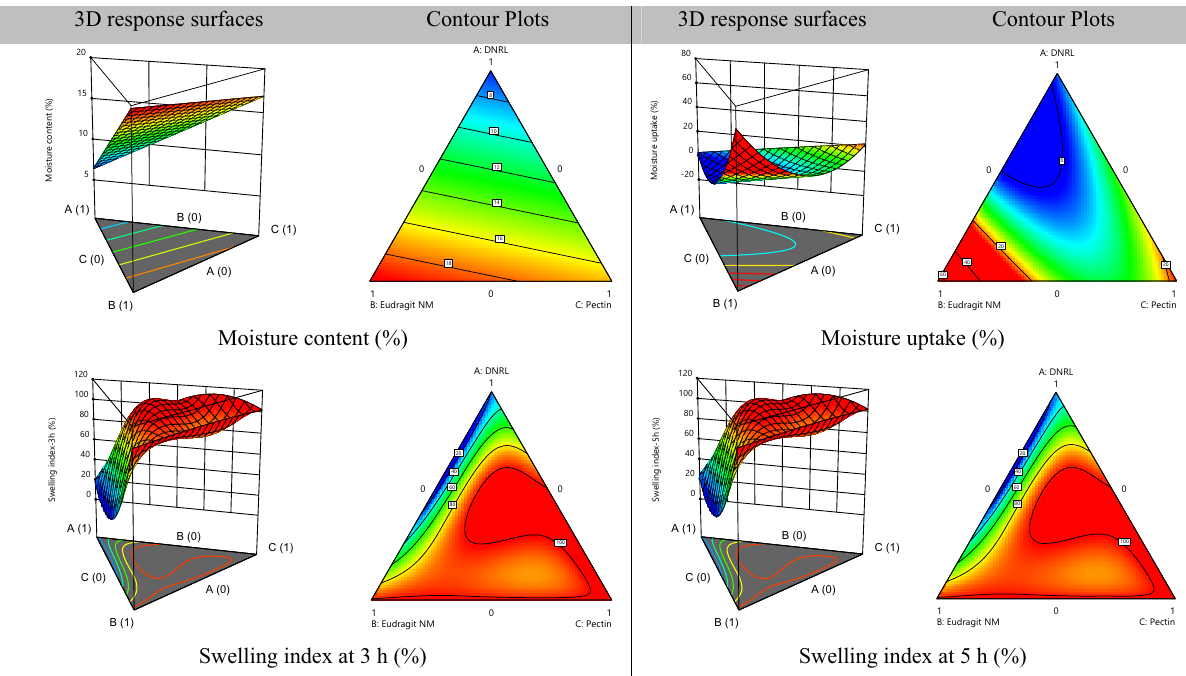
Figure 1: 3D response surface and contour plot of nicotine buccal fi lm formulations with di ff erent dependent variables: moisture content ( Y